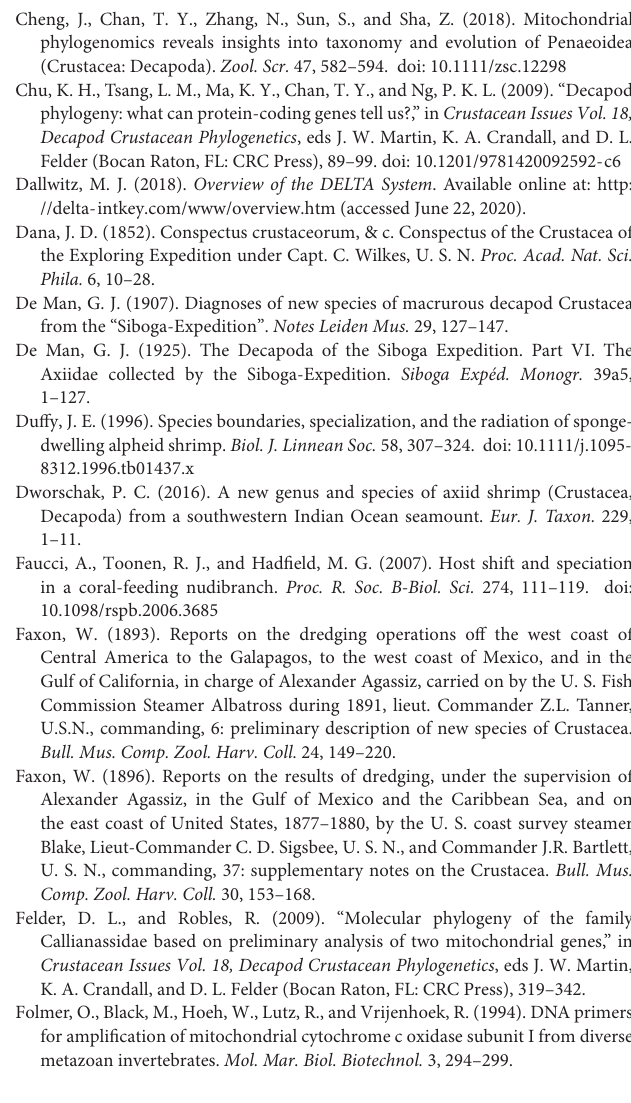
FIGURE S1 | (A) Codon usage of the mitochondrial genome of Eiconaxius serratus sp. nov. Numbers to the left refer to the total number of codons; (B) the relative synonymous codon usage (RSCU) of the mitochondrial genome of Eiconaxius serratus sp. nov. Numbers to the left refer to the total number of the RSCU values. Codon families are provided on the X axis. FIGURE S2 | Putative secondary structures for the 22 transfer RNAs of the of mitochondrial genome of Eiconaxius serratus sp. nov. FIGURE S3 | Bayesian tree inferred from the concatenated 13 mitochondrial pro PCGs nucleotide sequences partitioned by gene. Nodal supports are denoted on the corresponding branches, and the black asterisk ( ∗ ) indicates PP ≥ 0.95 for the node. TABLE S1 | The mitochondrial genomes sequences used in this